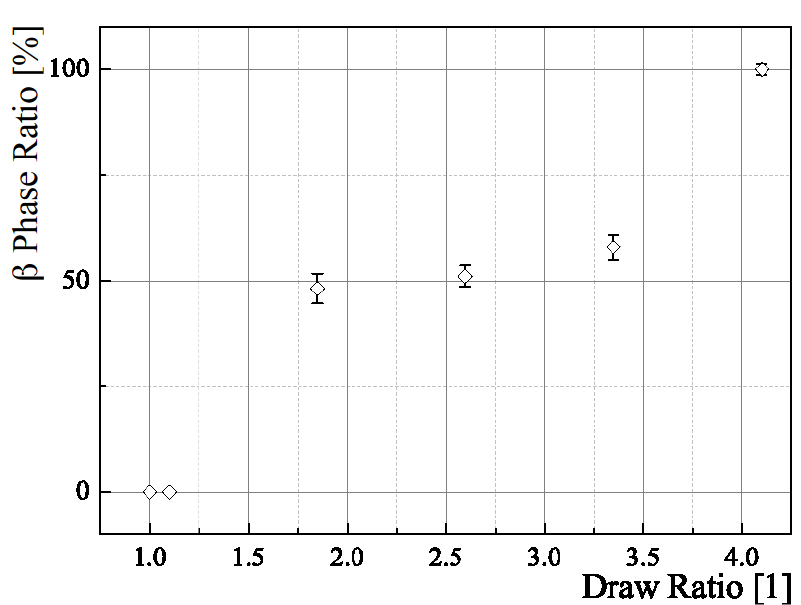
Figure 10. Sheath β phase content at different draw